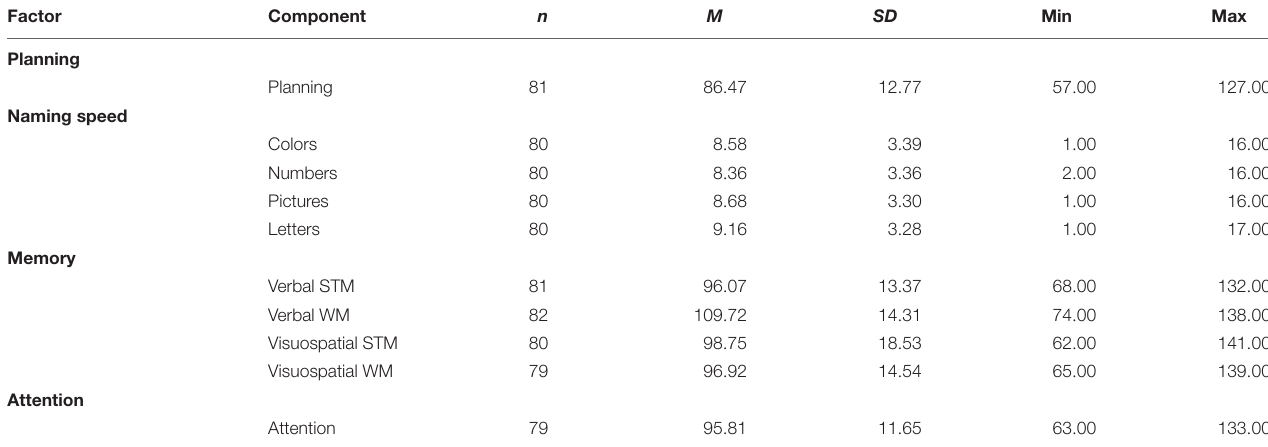
TABLE 2 | Descriptive statistics for each factor and component.